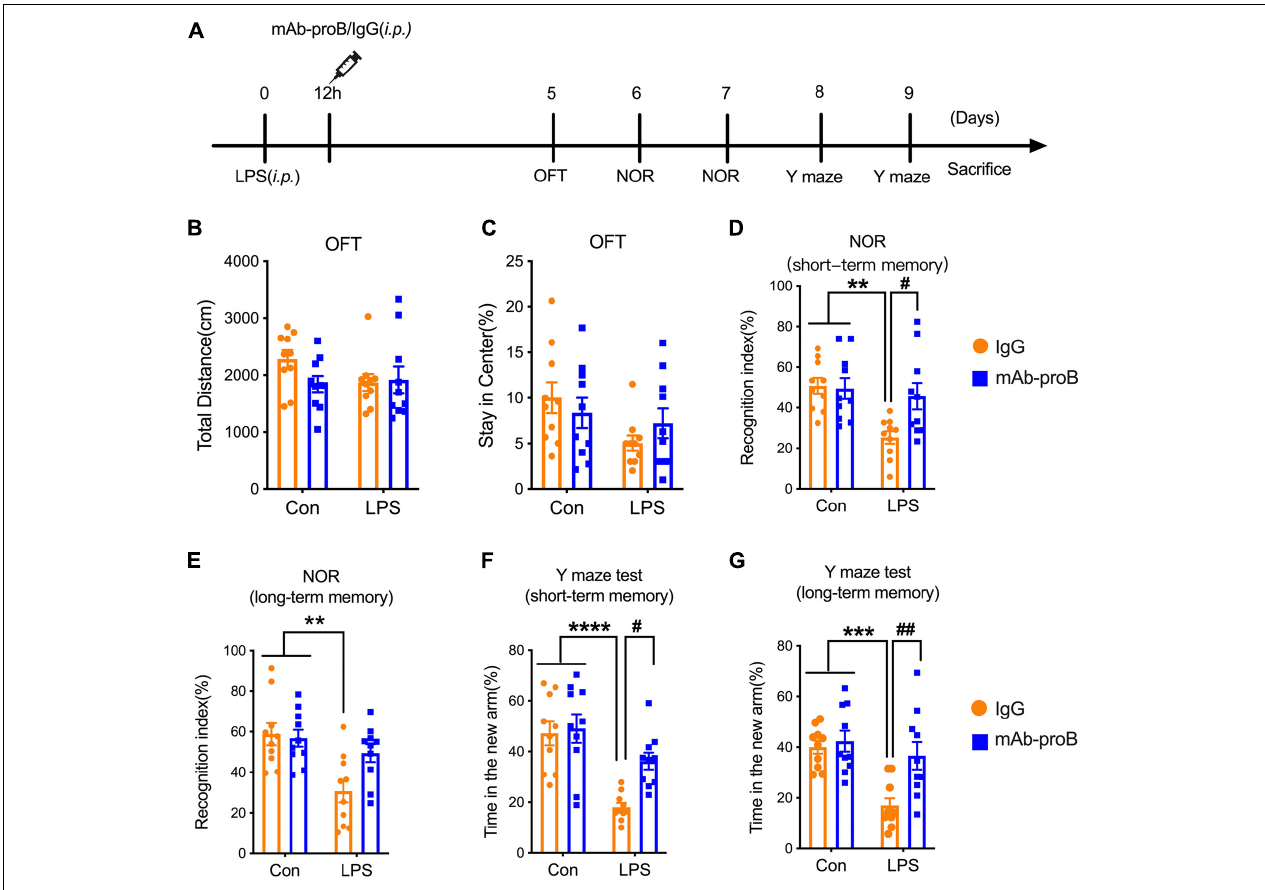
FIGURE 5 | Systemic delivery of neutralizing mAb-proB partially reversed the sepsis-associated encephalopathy-induced cognitive impairment. (A) The behavior schedule of the experiment. (B,C) The total distance traveled and percentage of time during which mice stay in the center of the field ( n = 9–10/group). (D,E) The recognition index of the short/long-term memory tasks of the novel object recognition test ( n = 10/group). (F,G) The percentage of time that mice stay in the novel arm of the short/long-term memory tasks in the Y maze test ( n = 10/group). Data are expressed as mean ± SEM. ** p < 0.01, *** p < 0.001, **** p < 0.0001 vs. control; # p < 0.05, ## p < 0.01, LPS + IgG vs. LPS +